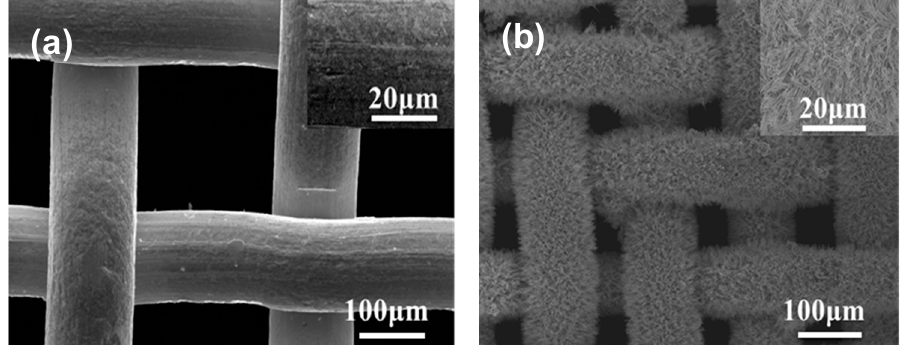
Figure 3. Scanning electron microscopy (SEM) images of ( a ) smooth copper mesh and ( b ) 60 min immersion in coating solution.